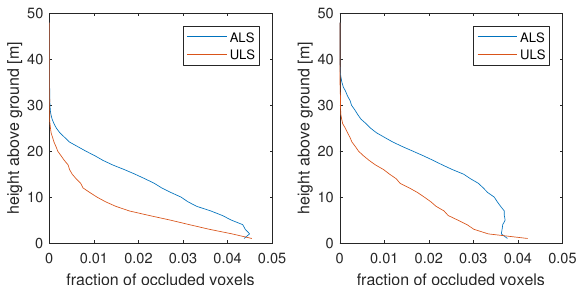
Figure 3. Fraction of occluded voxels in dependence of height above ground for the ALS and the ULS acquisitions. The plots show the occlusions for raster cell sizes of 1 m for site 1 (left) and site 2 (right). The reported fractions are relative to the total number of occluded voxels within the respective data set, which are reported in Table 1